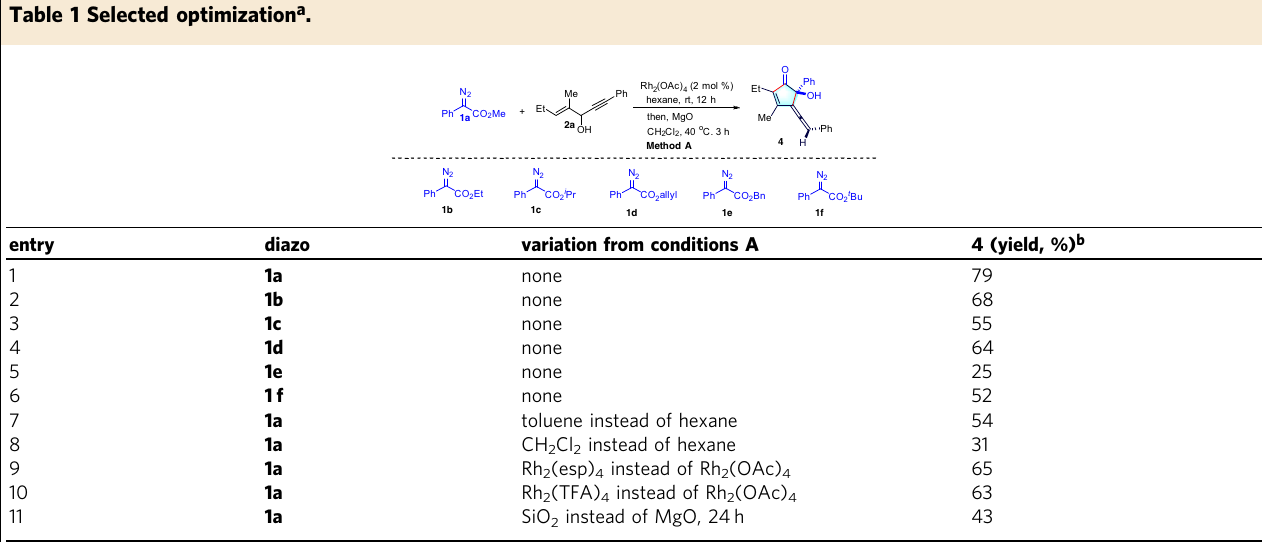
Table 1 Selected optimization a